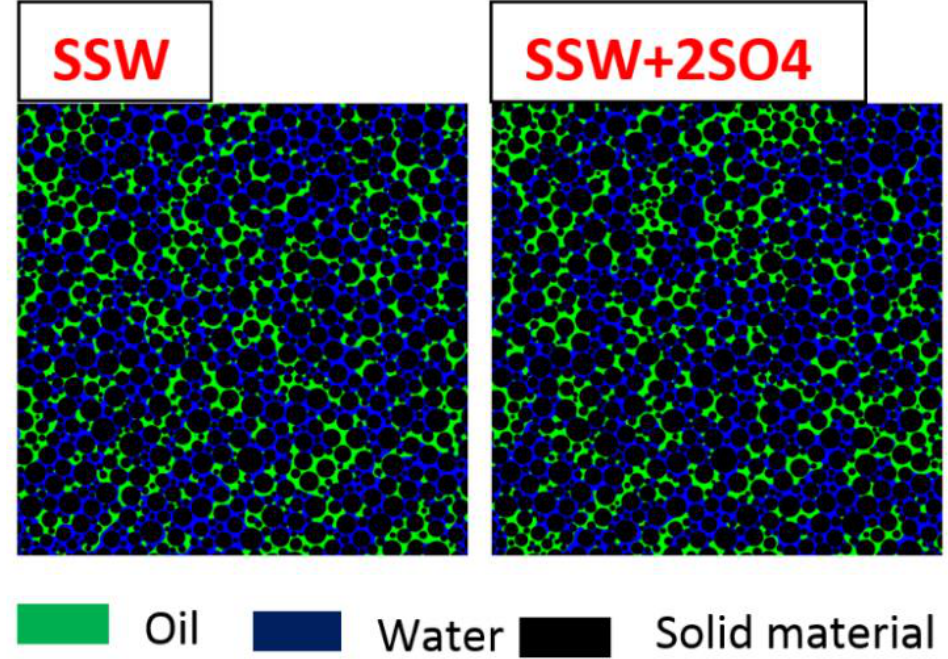
Figure 16. Real structure water-wet micromodels used for two injection brines mentioned in Table 2. Figure represents the oil recovery after 10PV injected brine.